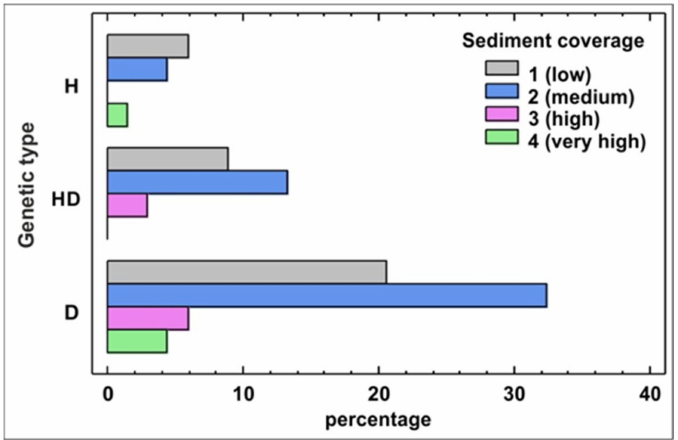
Figure 12. Bar chart for genetic type by sediment coverage (SC) determined visually on the basis of